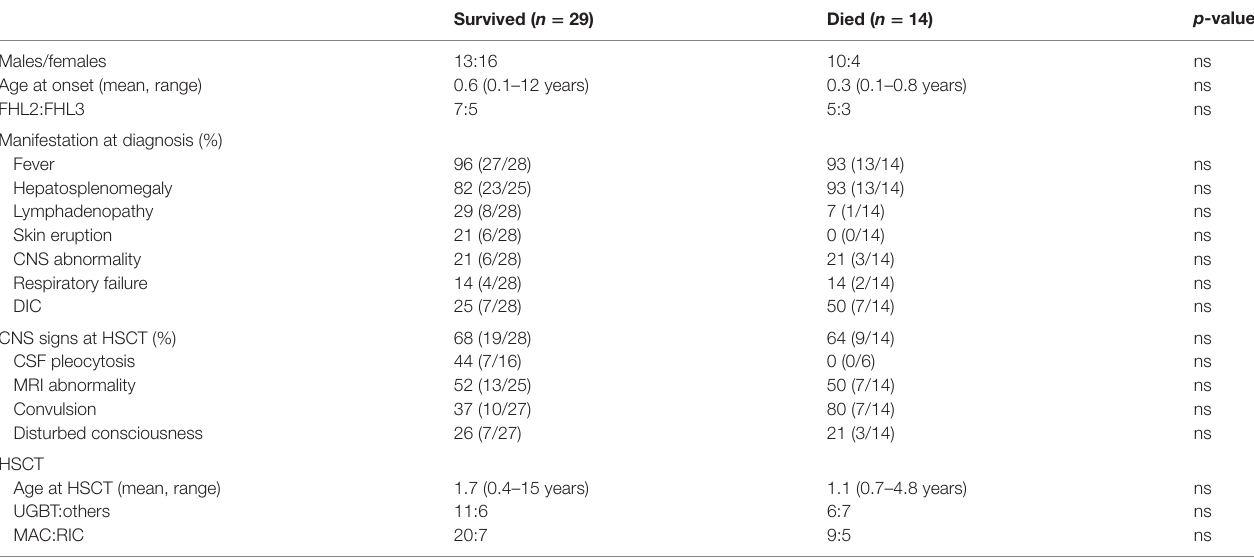
TABLe 3 | Profiles of survived and died FHL